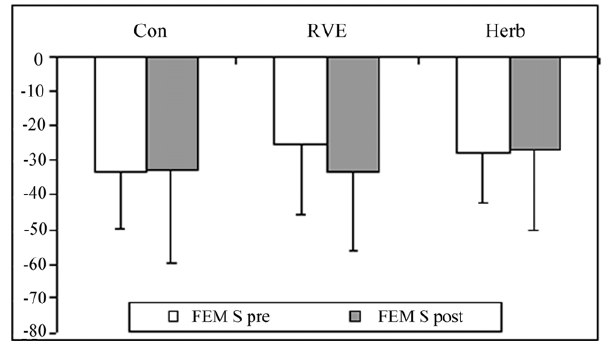
Figure 8. Percentage change in the tibial vein (Tib) section from supine to tilt positions. The Tib section was measured by echography as detailed in the Materials and Methods section. The percent change in Tib section from supine to tilt positions was significantly increased (P , 0.05) post-HDBR in Con and Herb groups, but not in the RVE gr. Only RVE CM contributed to maintain vein distension at the pre-HDBR level.